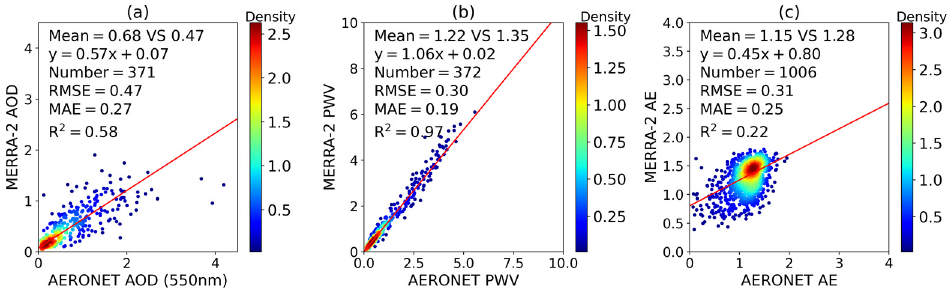
Figure 1. Validation of MERRA-2 against daily AERONET during 2005–2009. ( a ) AOD, ( b ) PWV, and ( c ) AE.